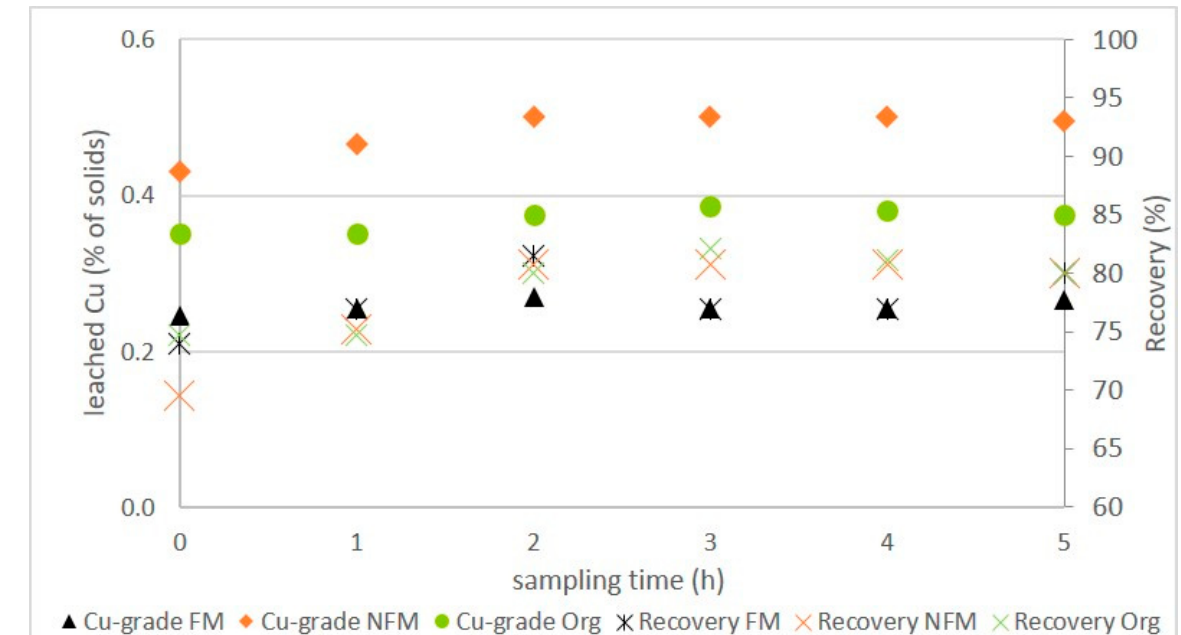
Figure 8. Processing scheme of magnetic separation in combination with leaching. Each test was carried out with around 8.5 kg sample material. FM: ferromagnetic, NFM: non ferromagnetic.